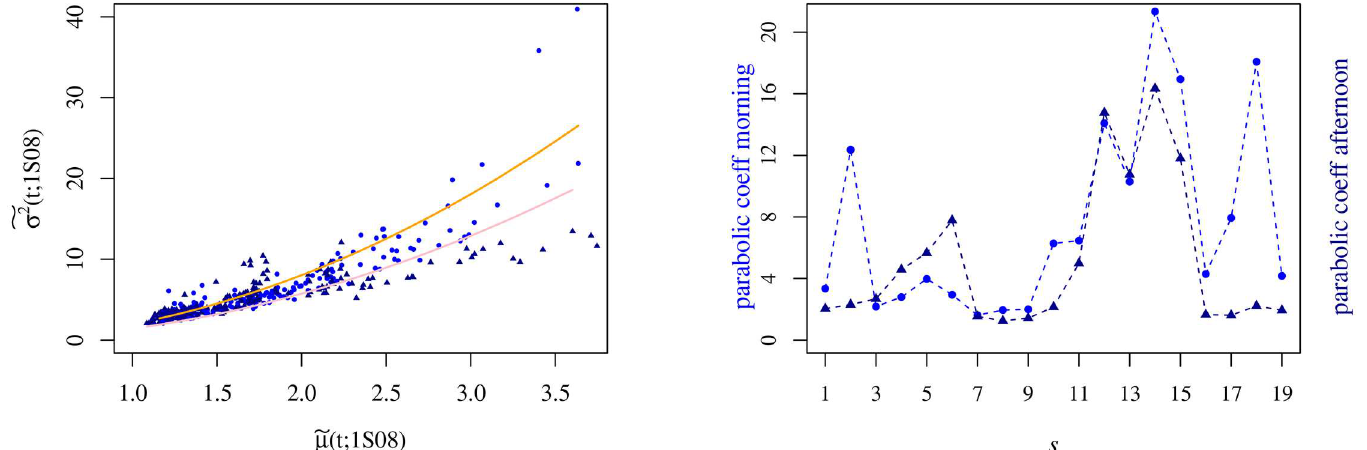
Fig 8. Relation between the varianceand the average of the trading volume in 1S08. For both panels the ultramarineblue dots represent the morning values and the navy blue triangles the afternoon ones. Left Panel: Variance v mean trading volume averagedover all the companiesfor s = 9. The values of ~ s 2 ð t ; s Þ and ~ m ð t ; s Þ are scaled by 10 8 and 10 4 , respectively. The orange and the pink lines represent the parabolic fit for curves of the morning and the afternoon periods yieldingthe followingparameters: 2.01 ± 0.06 and 1.43 ± 0.04, respectively. Right panel: Value of the paraboliccoefficient of the morning and the afternoon parts of the trading session as a function of the